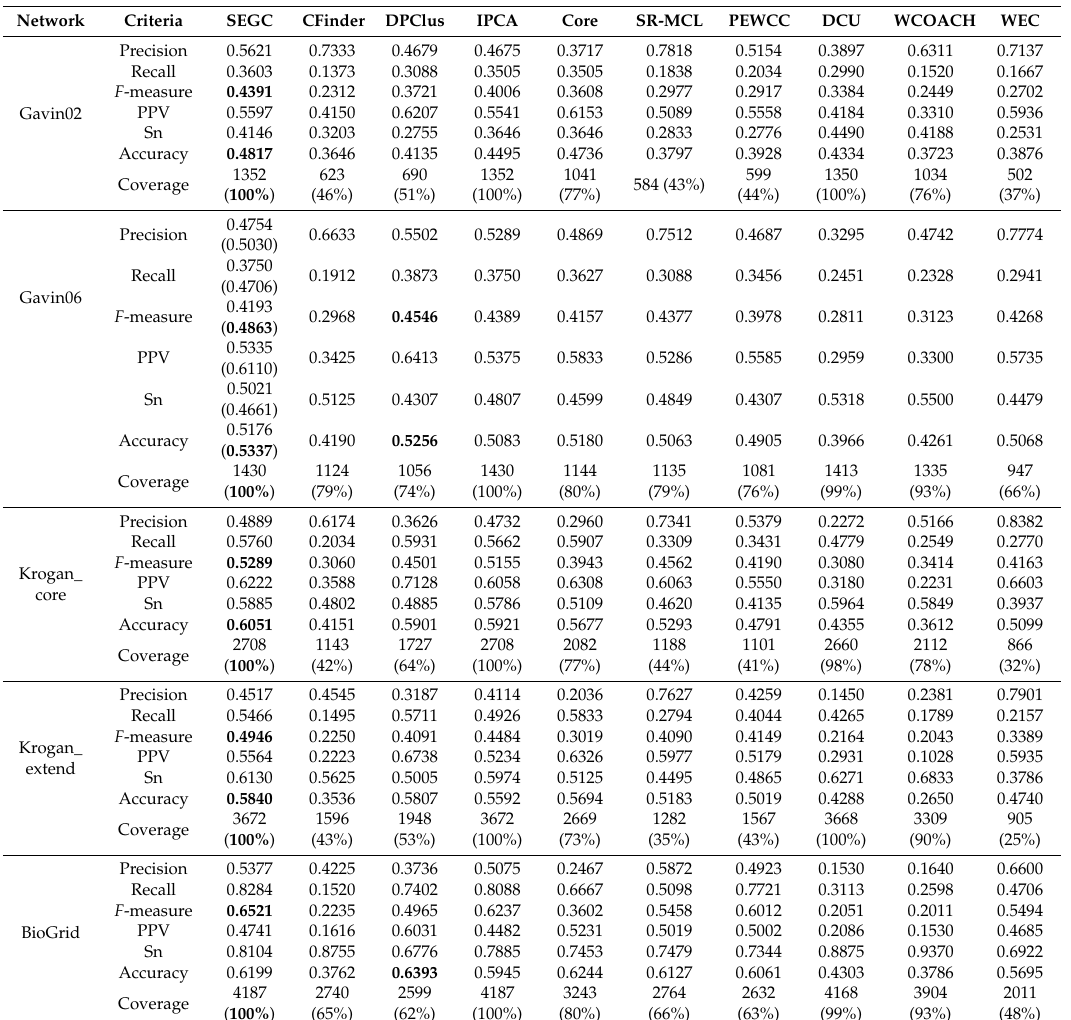
Table 5. The evaluation results by different algorithms on five PPI networks.